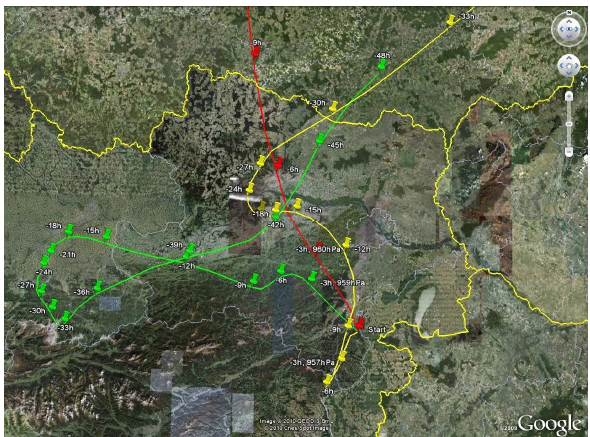
Figure 3. Ground-level 48h backward trajectories arriving on 23 April 2009, at 01:00 (yellow line), 04:00 (green line) and 07:00 (red line) local time (UTC +